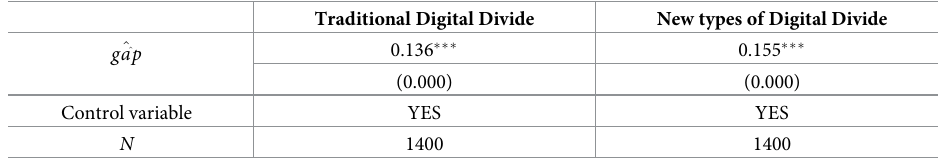
Table 10. Different types based on the digital